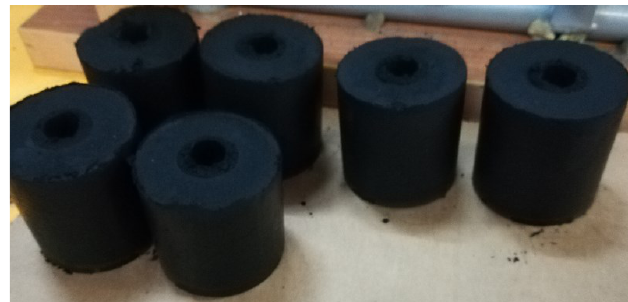
Figure 10. Removal of underburnt by flotation. The resulting underburnt is briquetted and used as fuel (Figure 11). Table 2 lists the chemical composition of the underburnt.